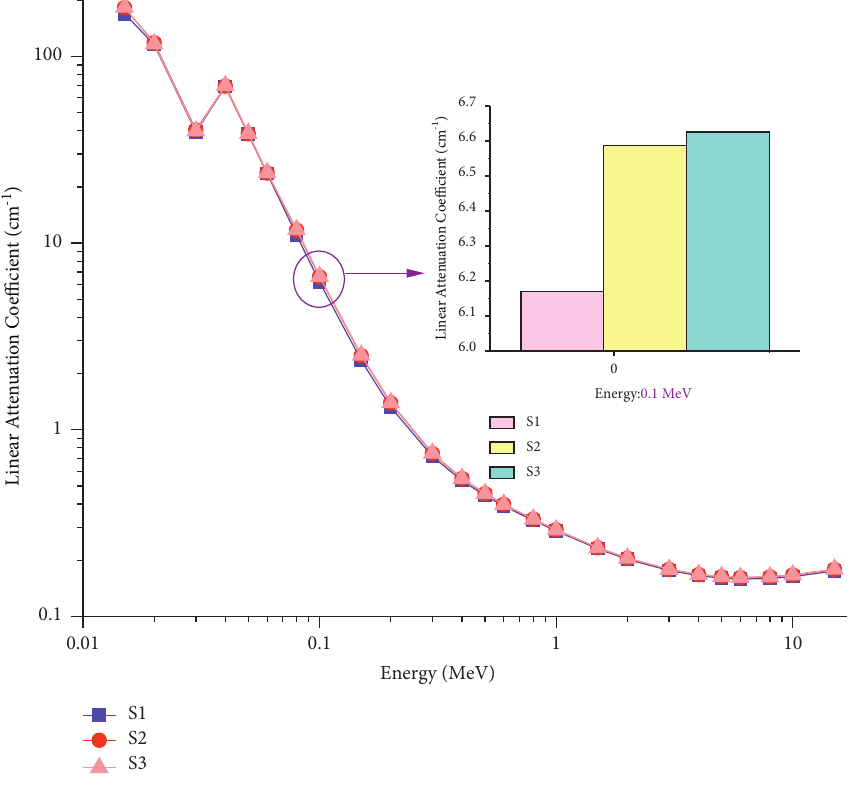
Figure 3: Variations of the linear attenuation coefficient (cm − 1 ) with photon energy (MeV) for all S1–S3 glasses.